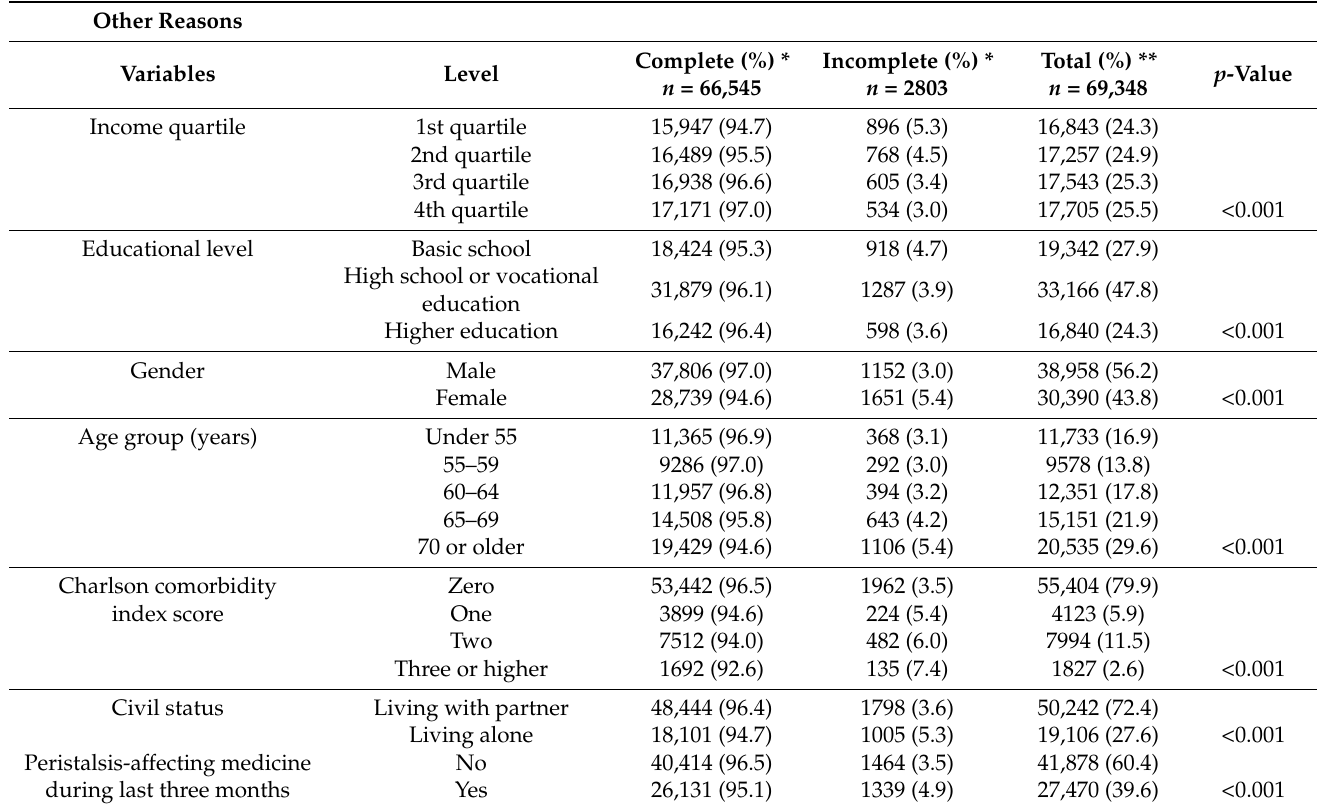
Table 2. Characteristics of the study population stratified by incomplete colonoscopy due to other